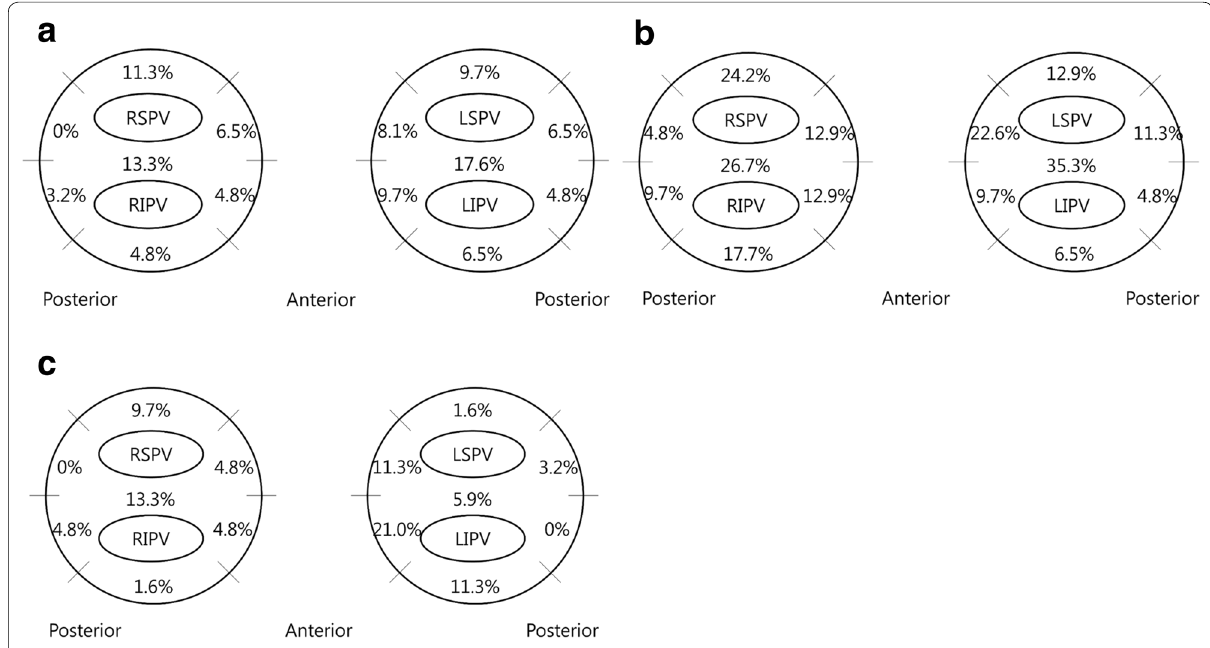
Fig. 3 Prevalence of gaps using Criterion criteria 1 ( a ), Criterion 2 ( b ), and Criterion 3 ( c